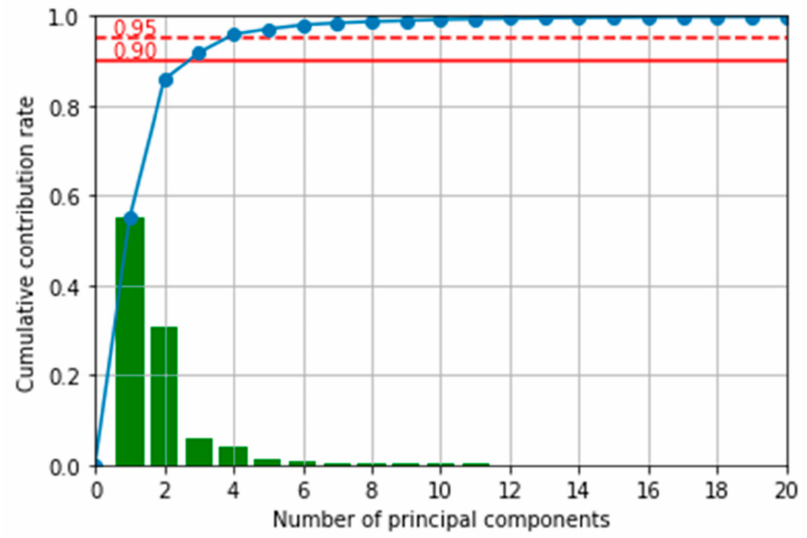
Figure 7. The cumulative contribution rate of components from PCA. The X-axis represents PCs sorted in ascending order of contribution rate, while the bar and line charts of the Y-axis represent contribution rates and cumulative contribution rates,